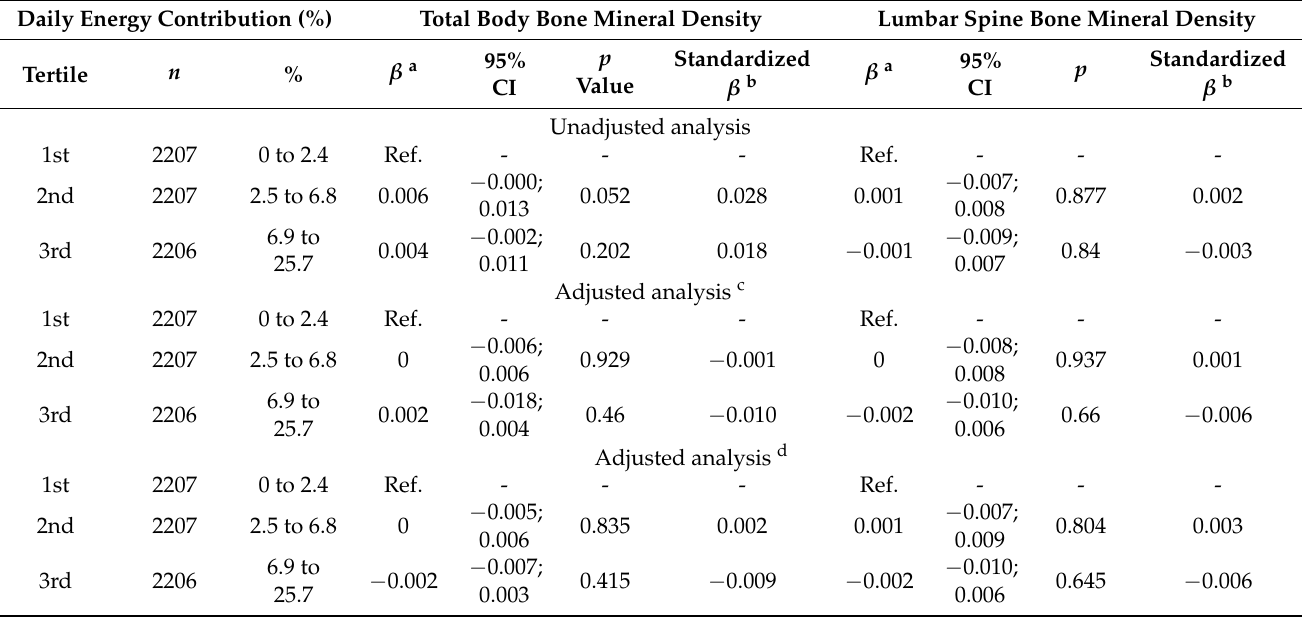
Table 5. Association between the daily energy contribution of sugar-sweetened beverages and